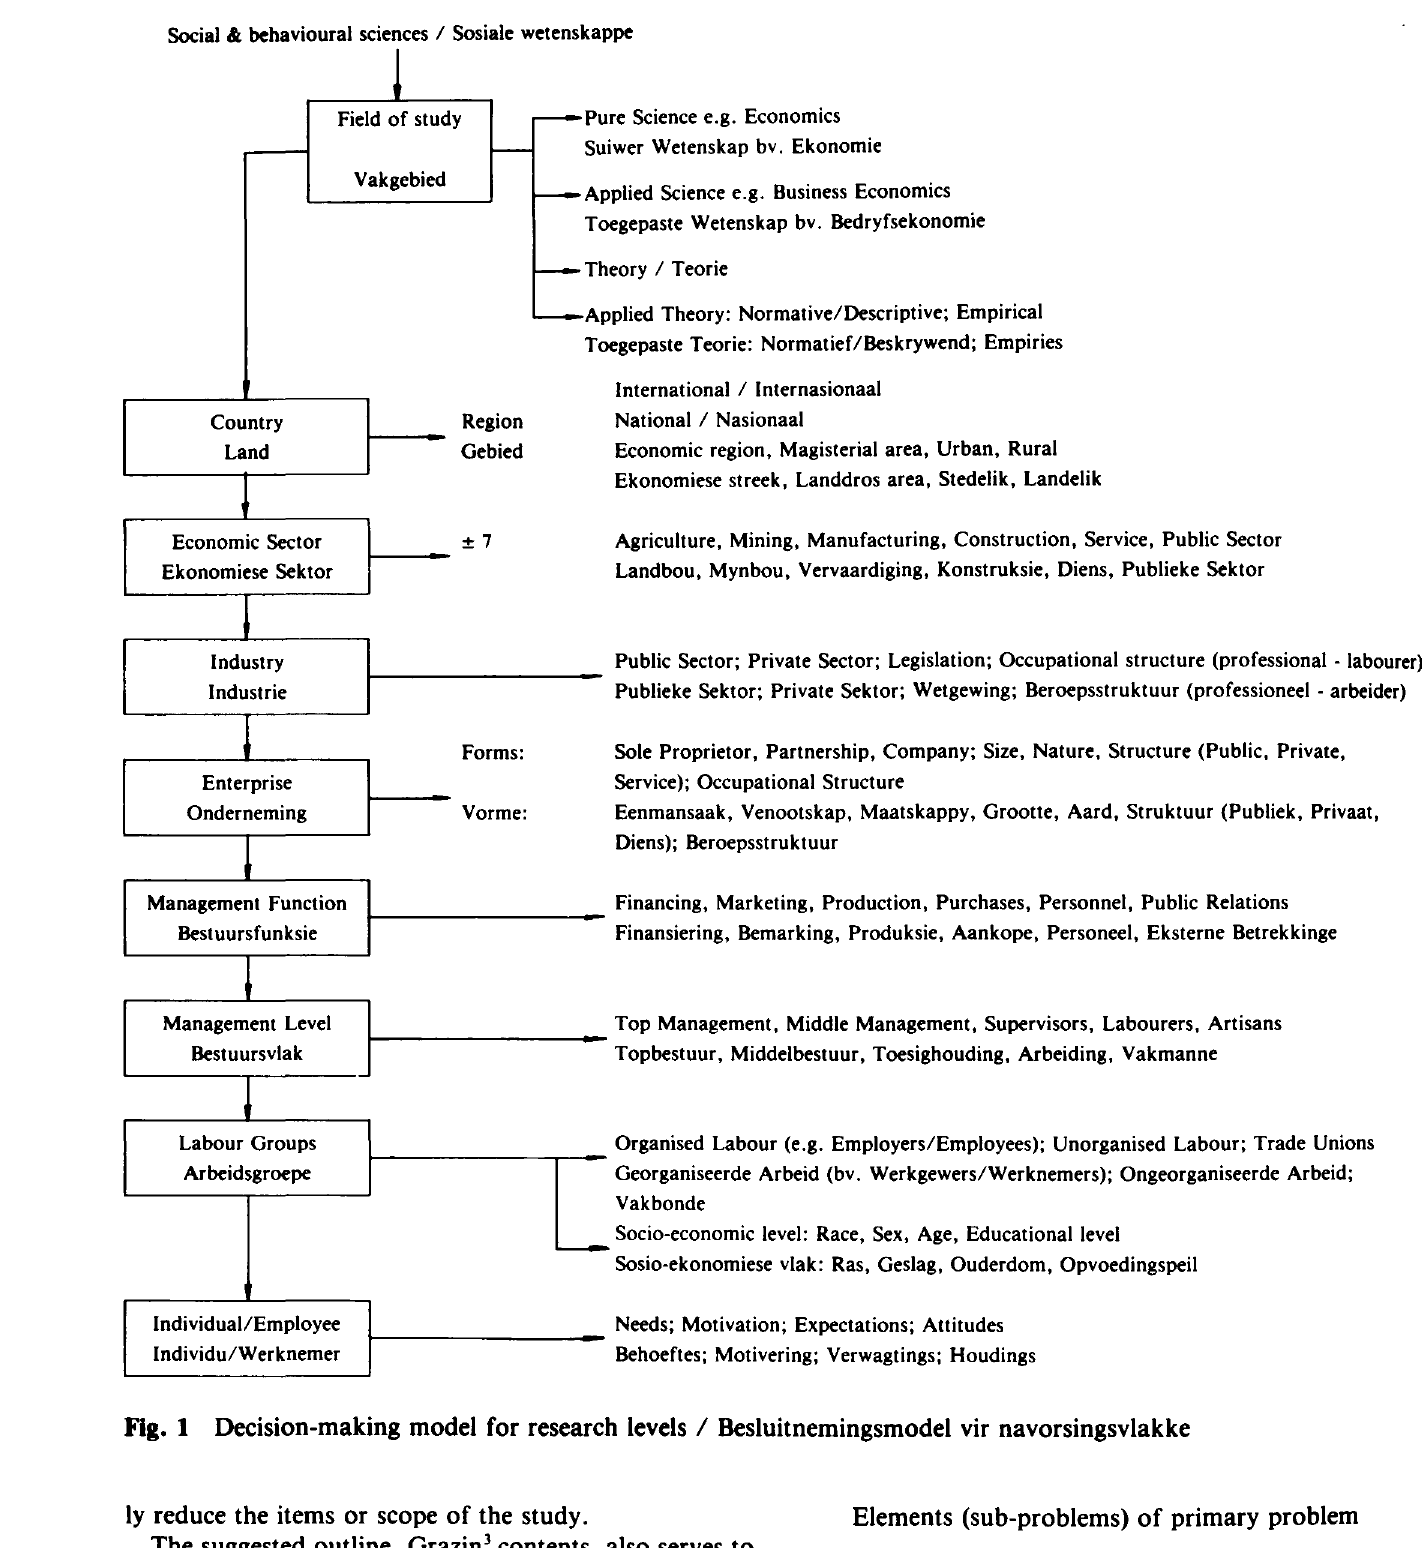
Fig. 1 Decision-making model for research levels / Besluitnemingsmodel vir navorsingsvlakke ly reduce the items or scope of the